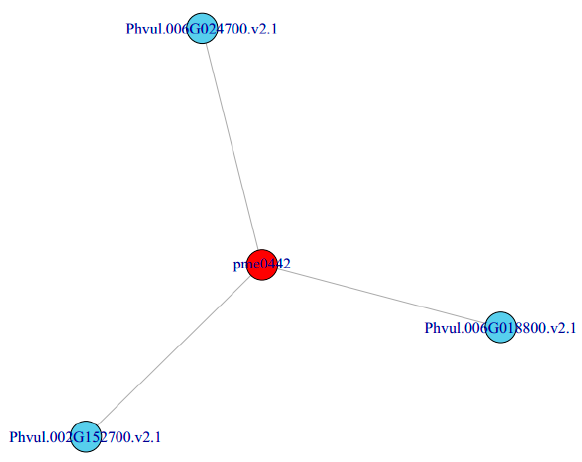
Figure 6. Correlation network of metabolites and genes. 2.8. Upregulation of F3 (cid:48) 5 (cid:48) H Expression Leads to Increased Levels of Three Anthocyanins in